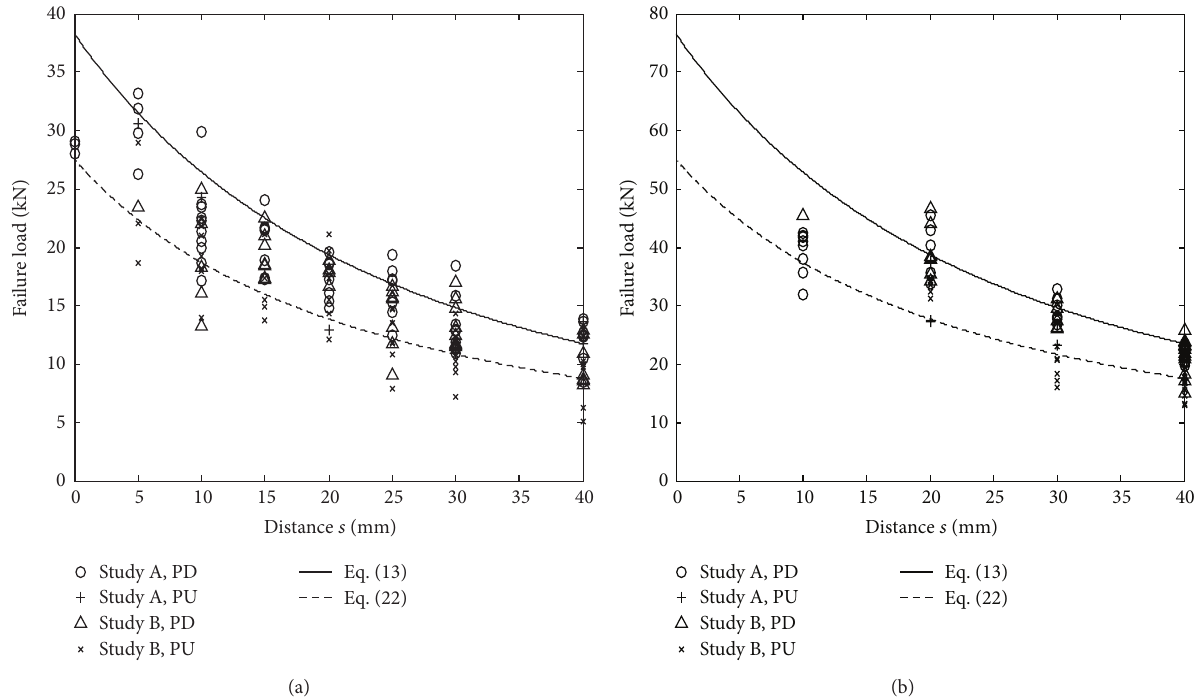
Figure 14: Comparison between theory and experiments for vertical cracking of a bottom rail assuming a finite initial crack length. (a) Specimens with single-sided sheathing and (b) specimens with double-sided sheathing. PD = pith downwards, PU = pith